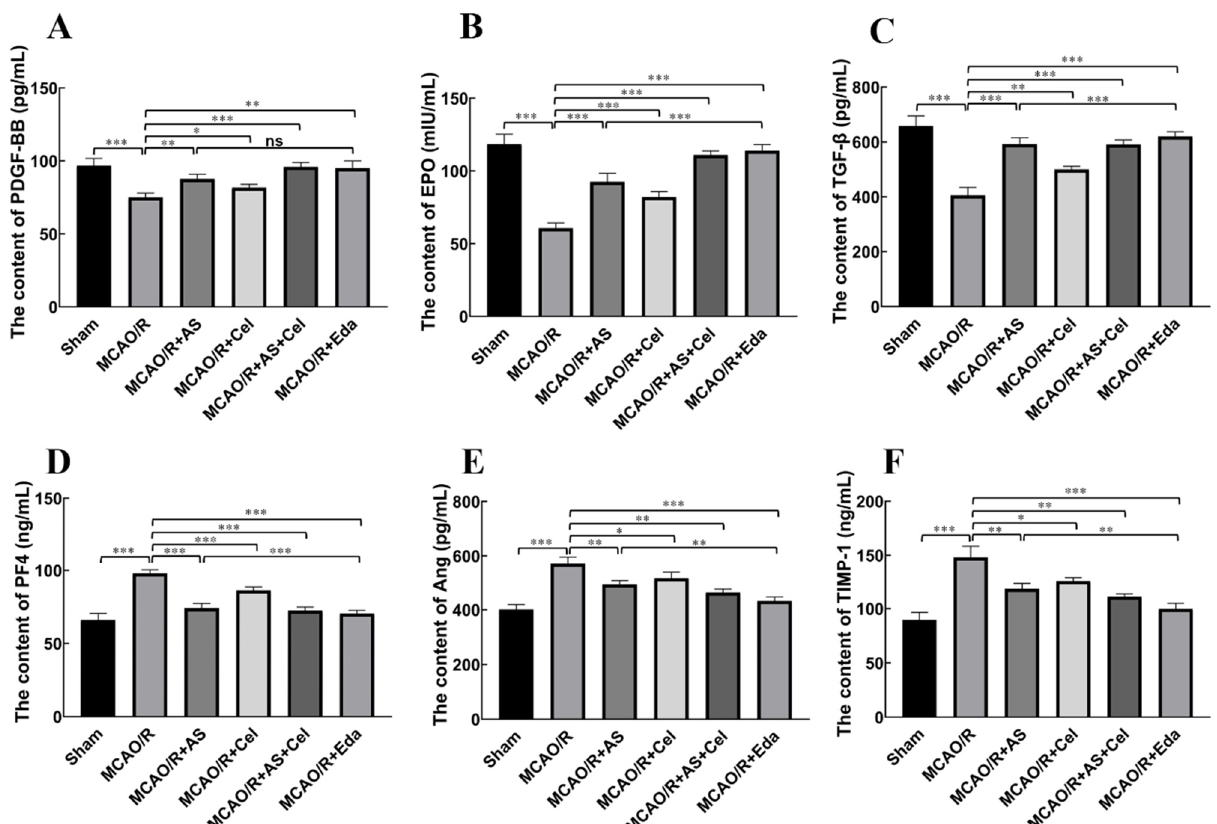
Figure 4. AS regulated the expression of PDGF ‐ BB ( A ), EPO ( B ), TGF ‐β ( C ), PF4 ( D ), Ang ‐ 2 ( E ), and TIMP ‐ 1 ( F ) (n = 6 rats for each group). Data are expressed as the mean ± SD, * p < 0.05; ** p < 0.01; *** p < 0.001; ns stands for no statistical significance.